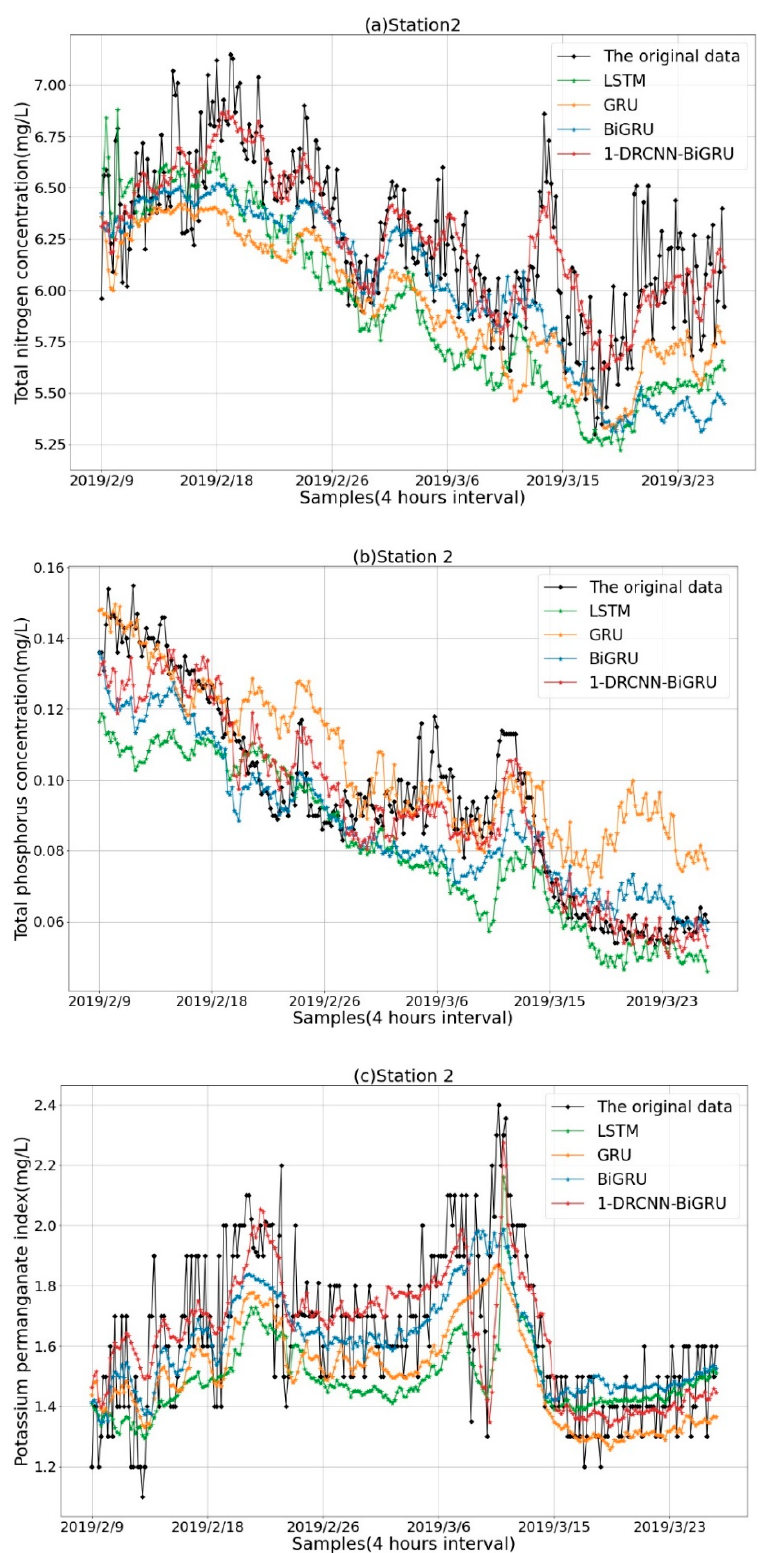
Figure 8. ( a ) Prediction results of total nitrogen (TN) in station 2. ( b ) Prediction results of total phosphorus (TP) in station 2. ( c ) Prediction results of potassium permanganate index (COD-Mn) in station 2.